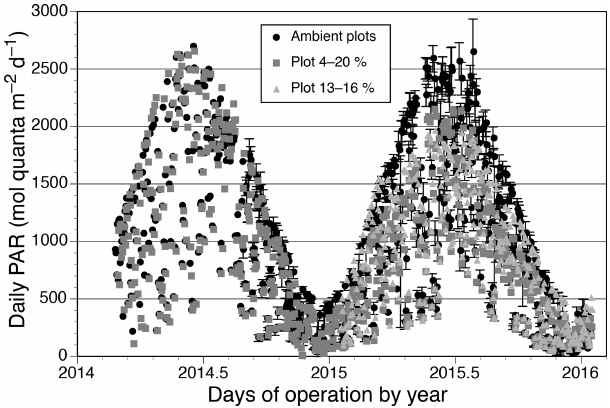
Figure 11. Example plot-center daily photosynthetically active ra- diation (PAR) at 2.5m above the bog surface in 2014 before en- closures were installed and after enclosure additions in 2015. The unchambered ambient plot data are from plot 7 (early in 2014) or the mean of plots 5, 7 and 21 with standard deviations shown. The figure legend shows the percent reduction in annual cumulative PAR associated with the presence of the enclosure infrastructure.